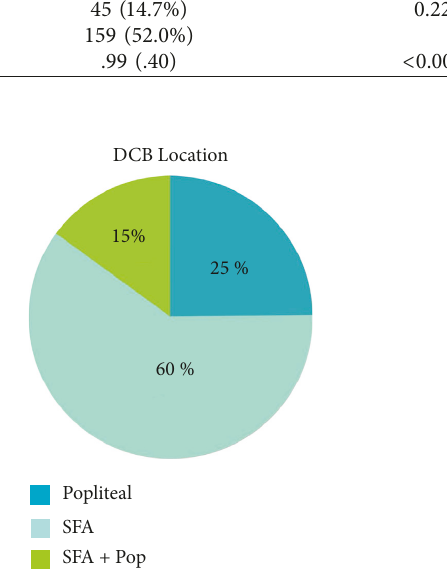
Figure 2: Locations of DCB placements. Similar breakdown in the location of DCB placement with the majority in SFA, although with higher percentage of patients undergoing intervention in popliteal and SFA/popliteal combination than seen in the DES counterparts. DCB � drug-coated balloons; Pop � popliteal; SFA � superficial femoral artery.